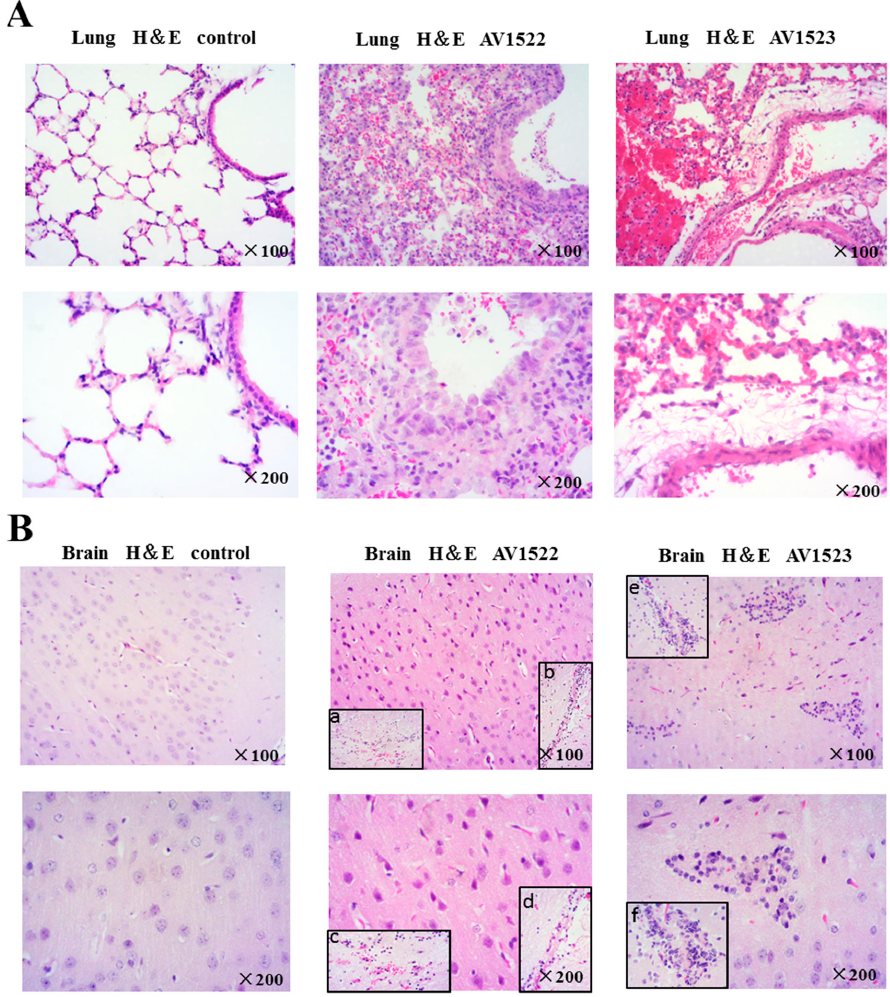
Figure 4. Histopathological examination of lung and brain tissues from mice infected with AV1522 virus or AV1523 virus. Representative images of hematoxylin-and-eosin staining tissues from mice